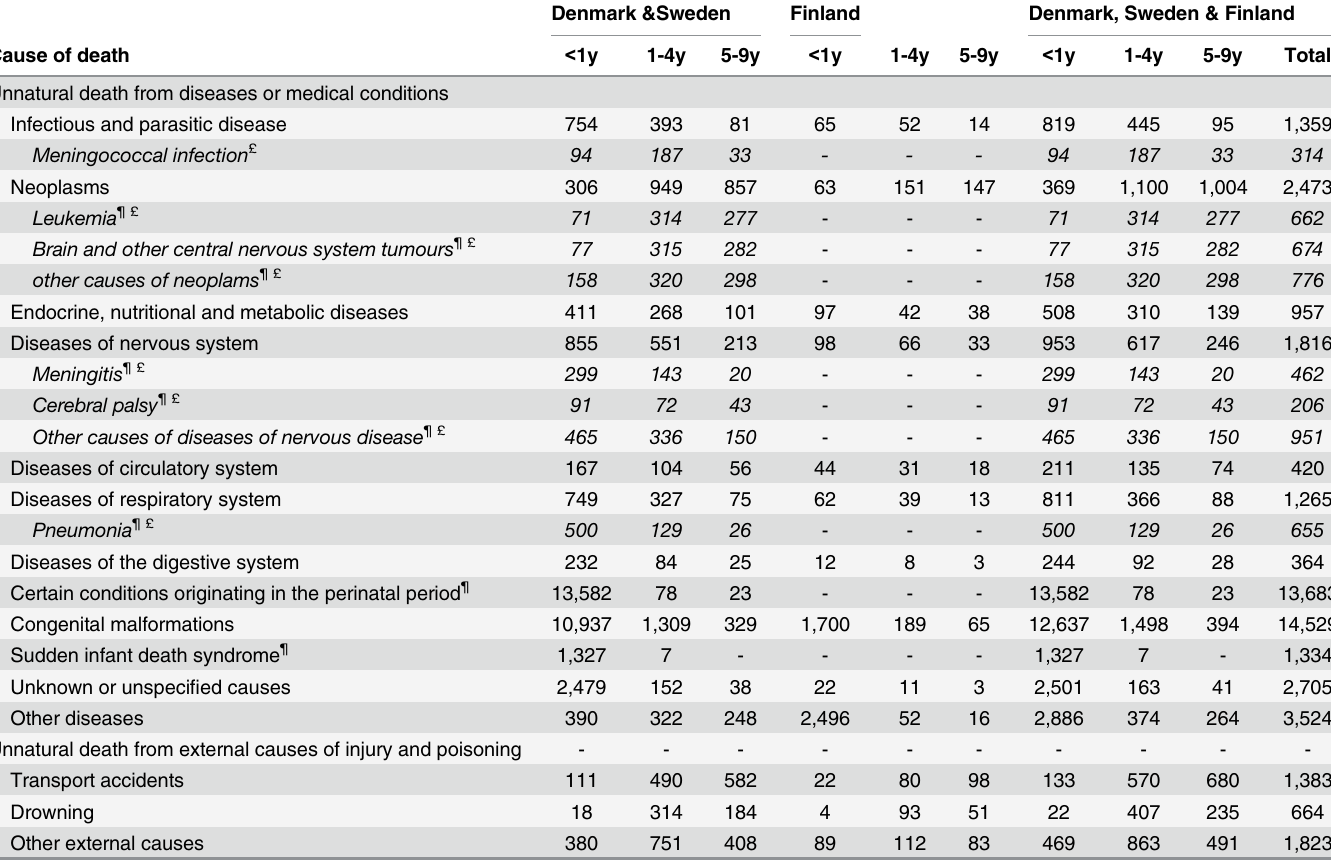
Table 1. The number of deaths by causes of death in aggregated